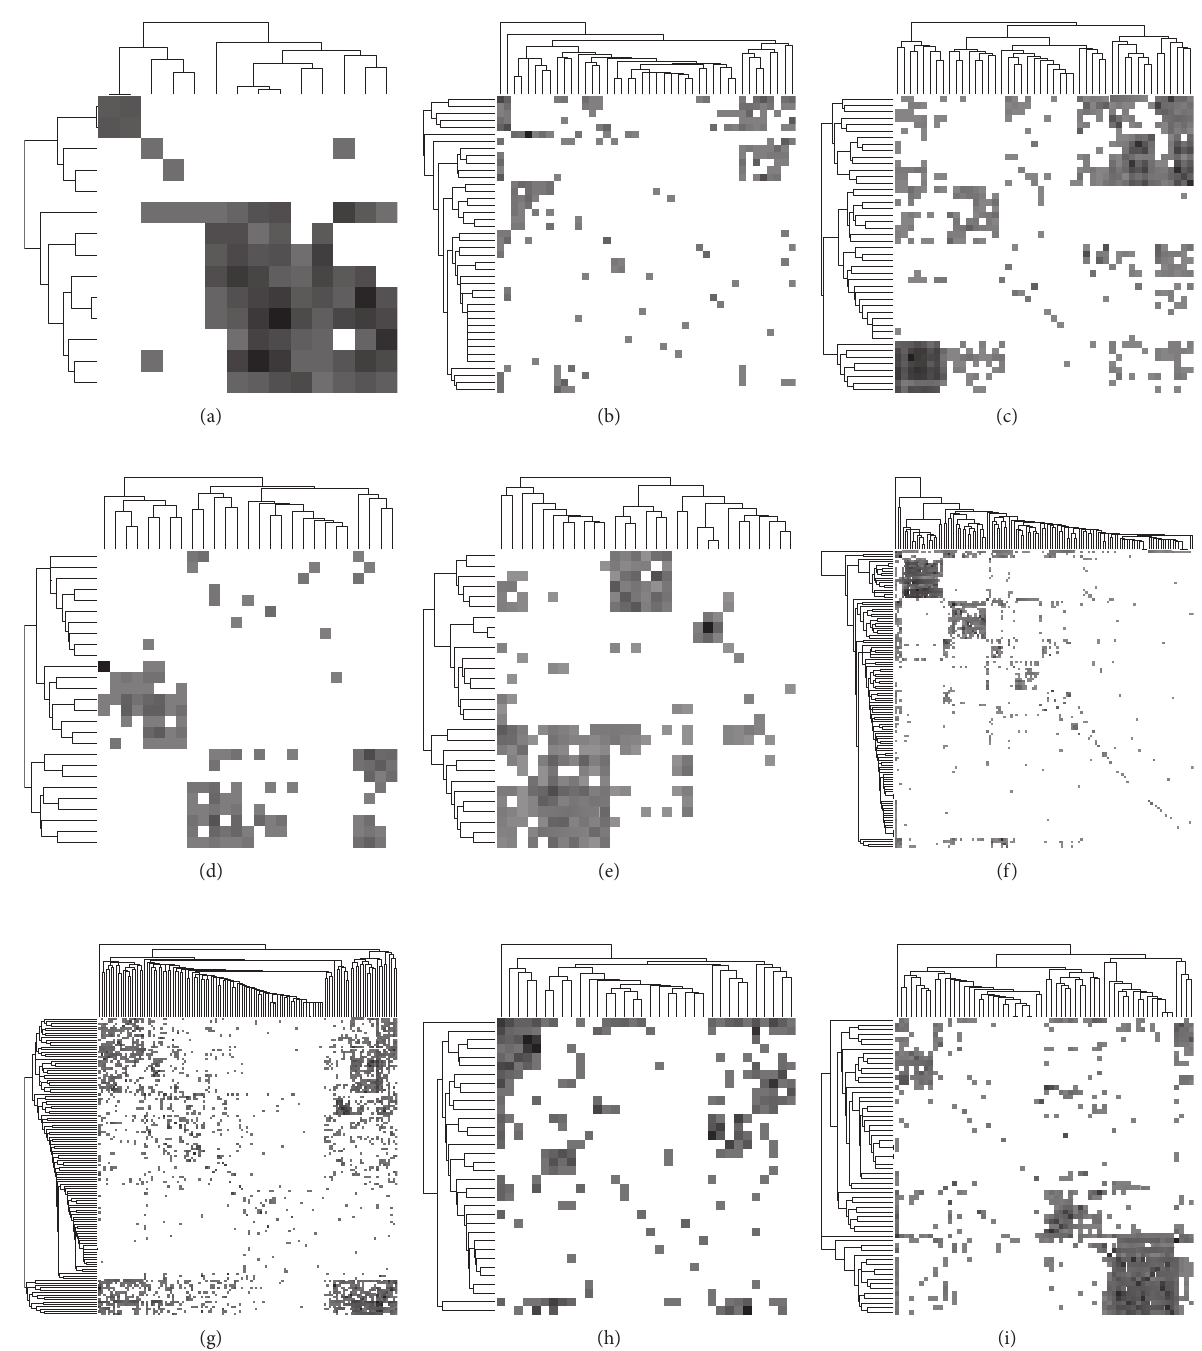
Figure 6: Clustered adjacency matrices of social communication networks from select enterprises. Color intensity indicates the log value of the number of weighted edges. Nodes are sorted using an agglomerative clustering algorithm [41, 42]. The dendrogram representing the sorting results is shown together with its respective